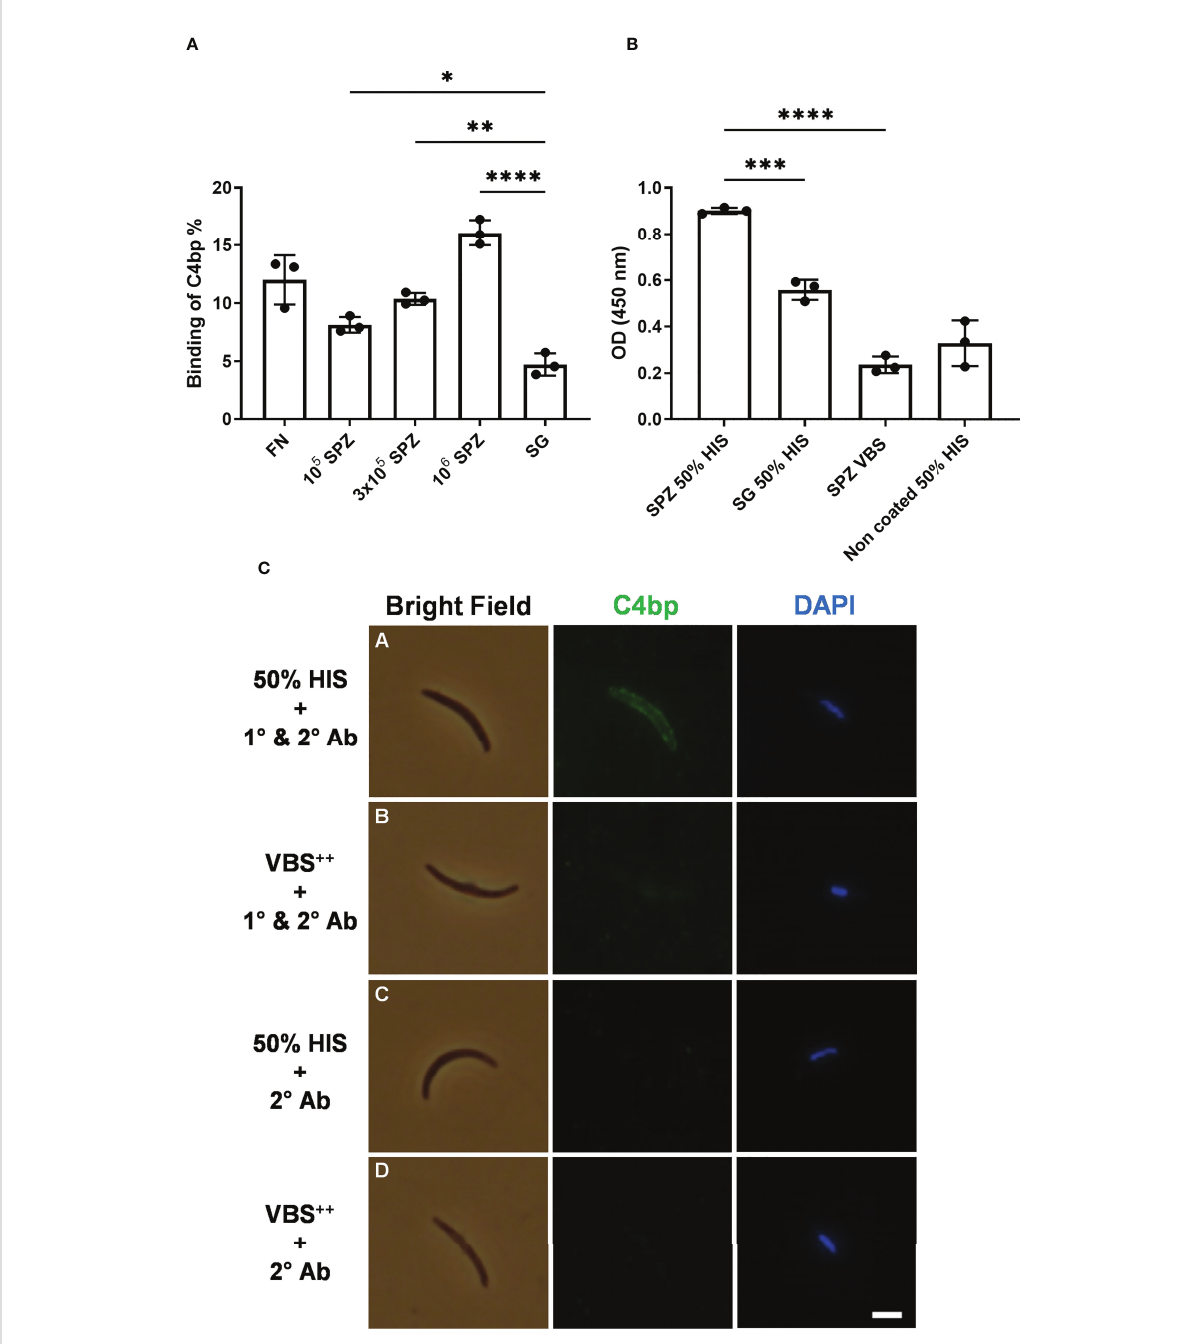
FIGURE 1 Binding of C4bp to SPZs. (A) Radiolabeled C4bp was incubated with Fusobacterium necrophorum (FN) bacteria (positive control) and with different amounts of P. falciparum SPZs or insoluble fraction of mosquito salivary glands (SG) (negative control). (B) Binding of serum C4bp to SPZs fi xed to the wells of microtiter plates was tested in a whole-SPZ ELISA. Bound C4bp was detected using sheep polyclonal anti-human C4bp, donkey anti-sheep IgG/HRP. Comparisons between groups were analyzed by ANOVA followed by post-hoc Tukey ’ s multiple pairwise comparisons test. The asterisks represent a signi fi cant difference between groups. (C) Binding of serum C4bp to the SPZ surface in indirect immuno fl uorescence assays (IFA). SPZs were incubated with either HIS (A, C) or VBS++ (B, D) and subjected to IFA. (A, B) The a -chain of C4bp (C4bp- a ) was labeled on the SPZ surface using primary antibodies (1°) against C4bp- a and detected with Alexa Fluor488-labeled (green) secondary antibody (2°). (C, D) As a secondary antibody control, SPZs were incubated with secondary antibody in the absence of primary antibody. Nuclei were detected by DAPI staining (blue). Asterisks indicate the p values: p < 0.05 = *; p < 0.01 = **; p < 0.001 = ***, and p < 0.0001 = ****. Scale bar, 3